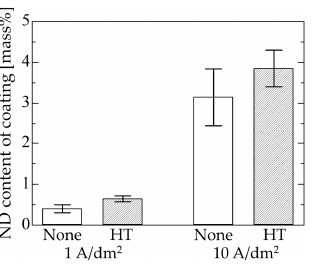
Figure 9. Effect of hydrothermal treatment on the ND content of the coating.